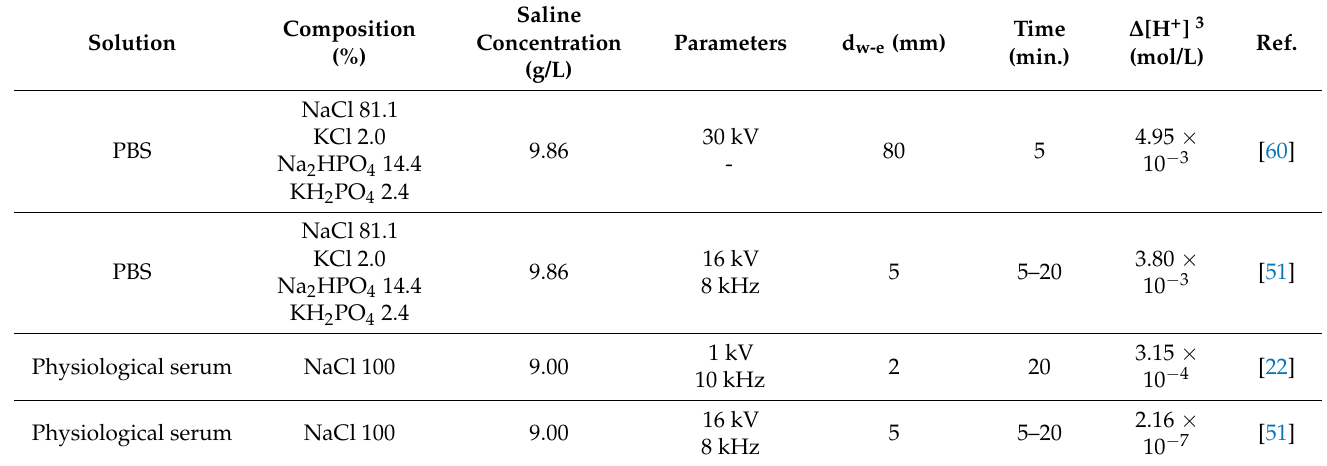
Table 4. Acidification of saline water by atmospheric plasma